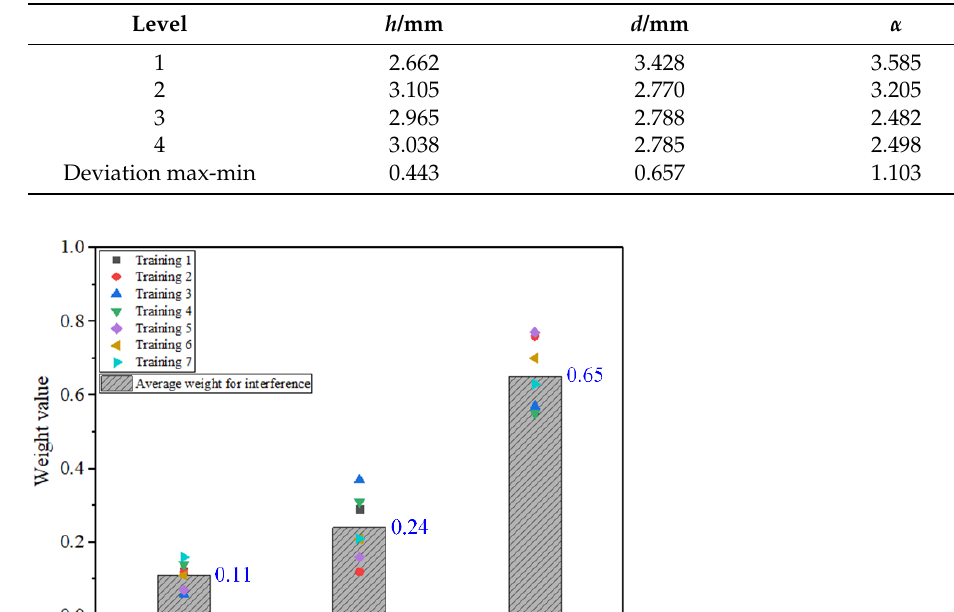
Table 4. The I max average of each variable.